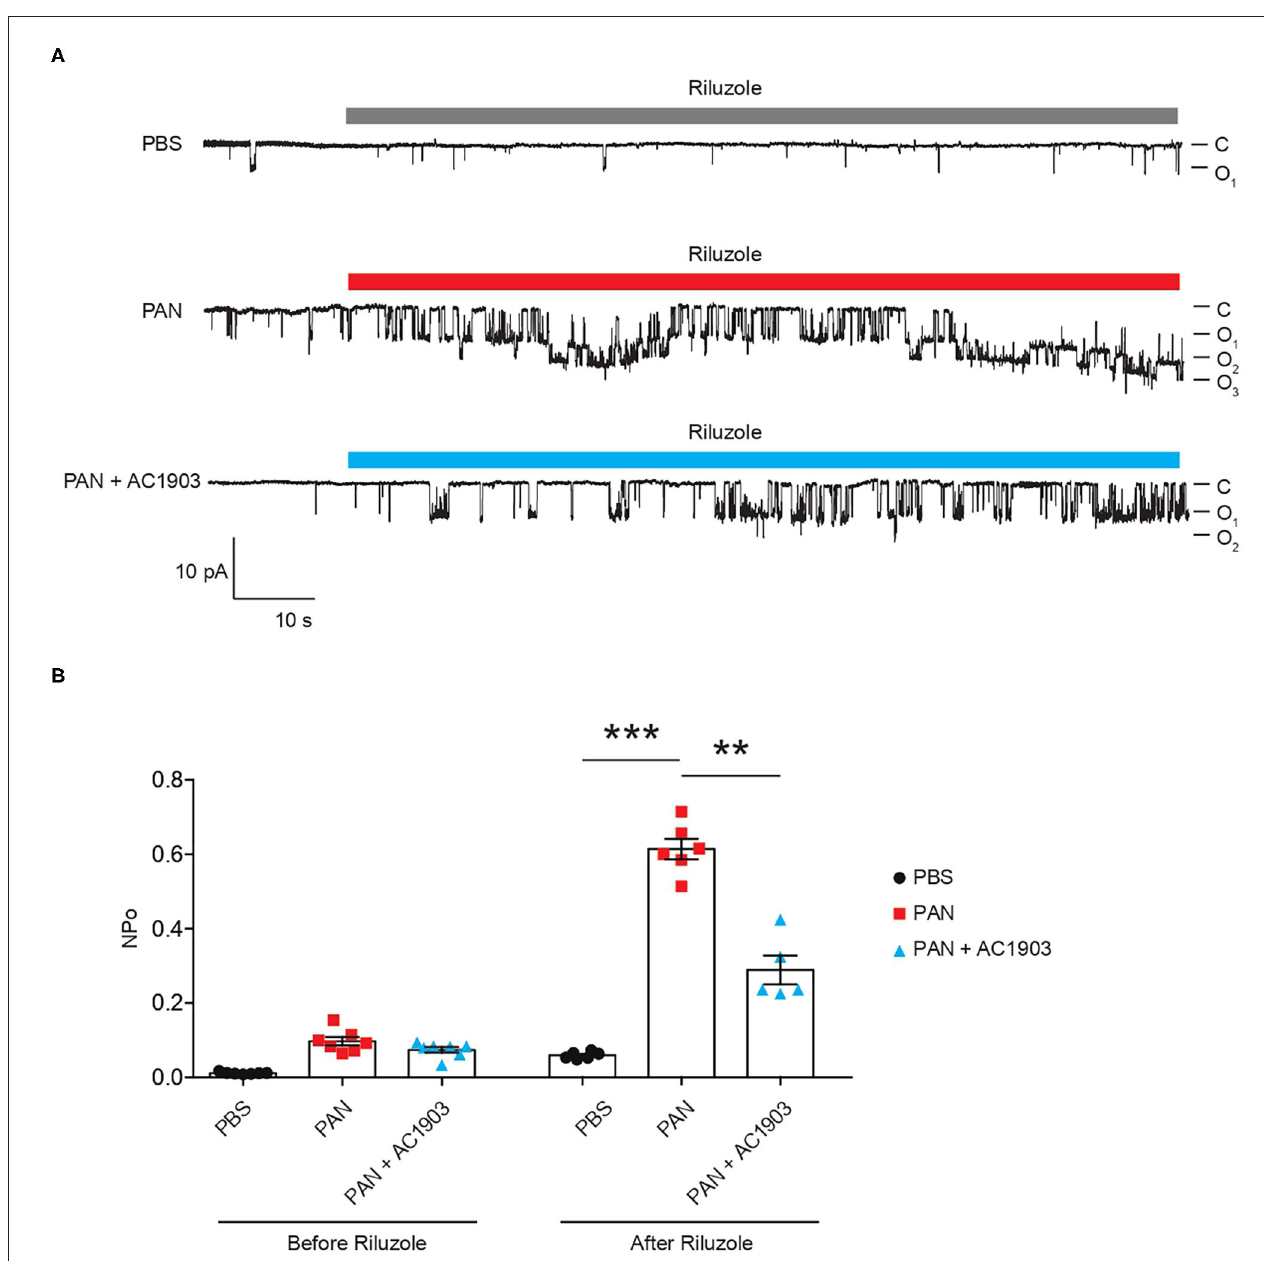
FIGURE 2 | Single-channel recordings from acutely isolated glomeruli show that systemic treatment with AC1903 abrogates TRPC5 activity. (A) Representative TRPC5 single-channel current traces from PBS, PAN and PAN + AC1903 treated rats in response to TRPC5 channel agonist Riluzole (30 µ M). (B) Quantification of TRPC5 single-channel activity by analysis of NPo values. ** p < 0.01, *** p <